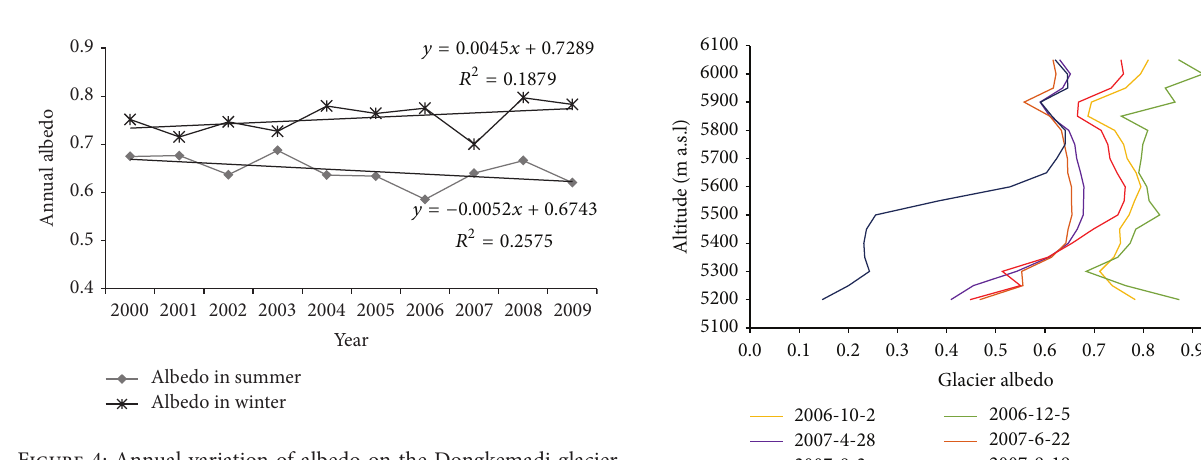
Figure 4: Annual variation of albedo on the Dongkemadi glacier from 2000 to 2009.